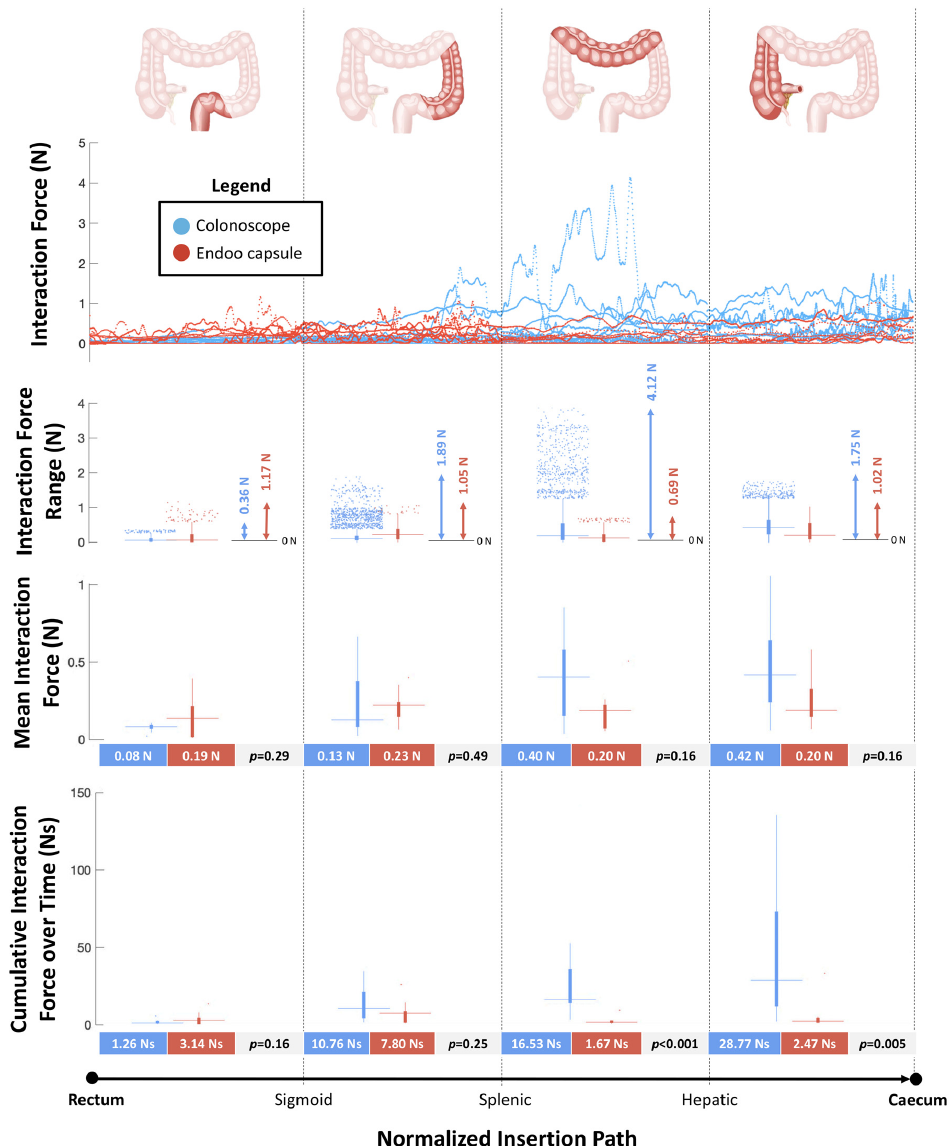
Figure 5. Interaction forces between the scopes (colonoscope and Endoo) and the anatomical structures (maximum output across six force sensors) as functions of the normalized insertion path from the rectum to the cecum. In each boxplot, the horizontal line displays the data median, while the vertical bars stand for data variability (25th and 75th percentiles, bold and thin whiskers, respectively) and the dots depict